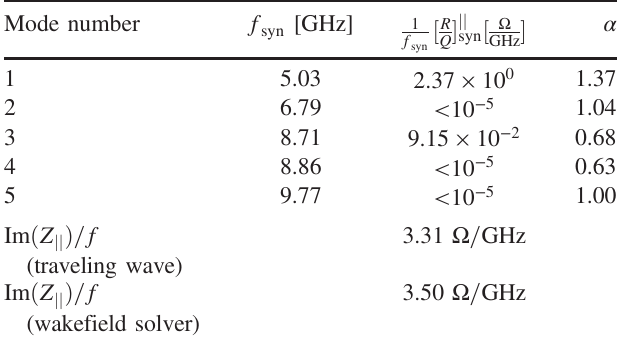
TABLE I. Longitudinal traveling wave data for one period of the bellows structure depicted in Fig. 3. The final result for Im ð Z jj Þ =f is the sum of the elements of the third column weighted with the corresponding factors α . The result of the wakefield solver is also shown for comparison.